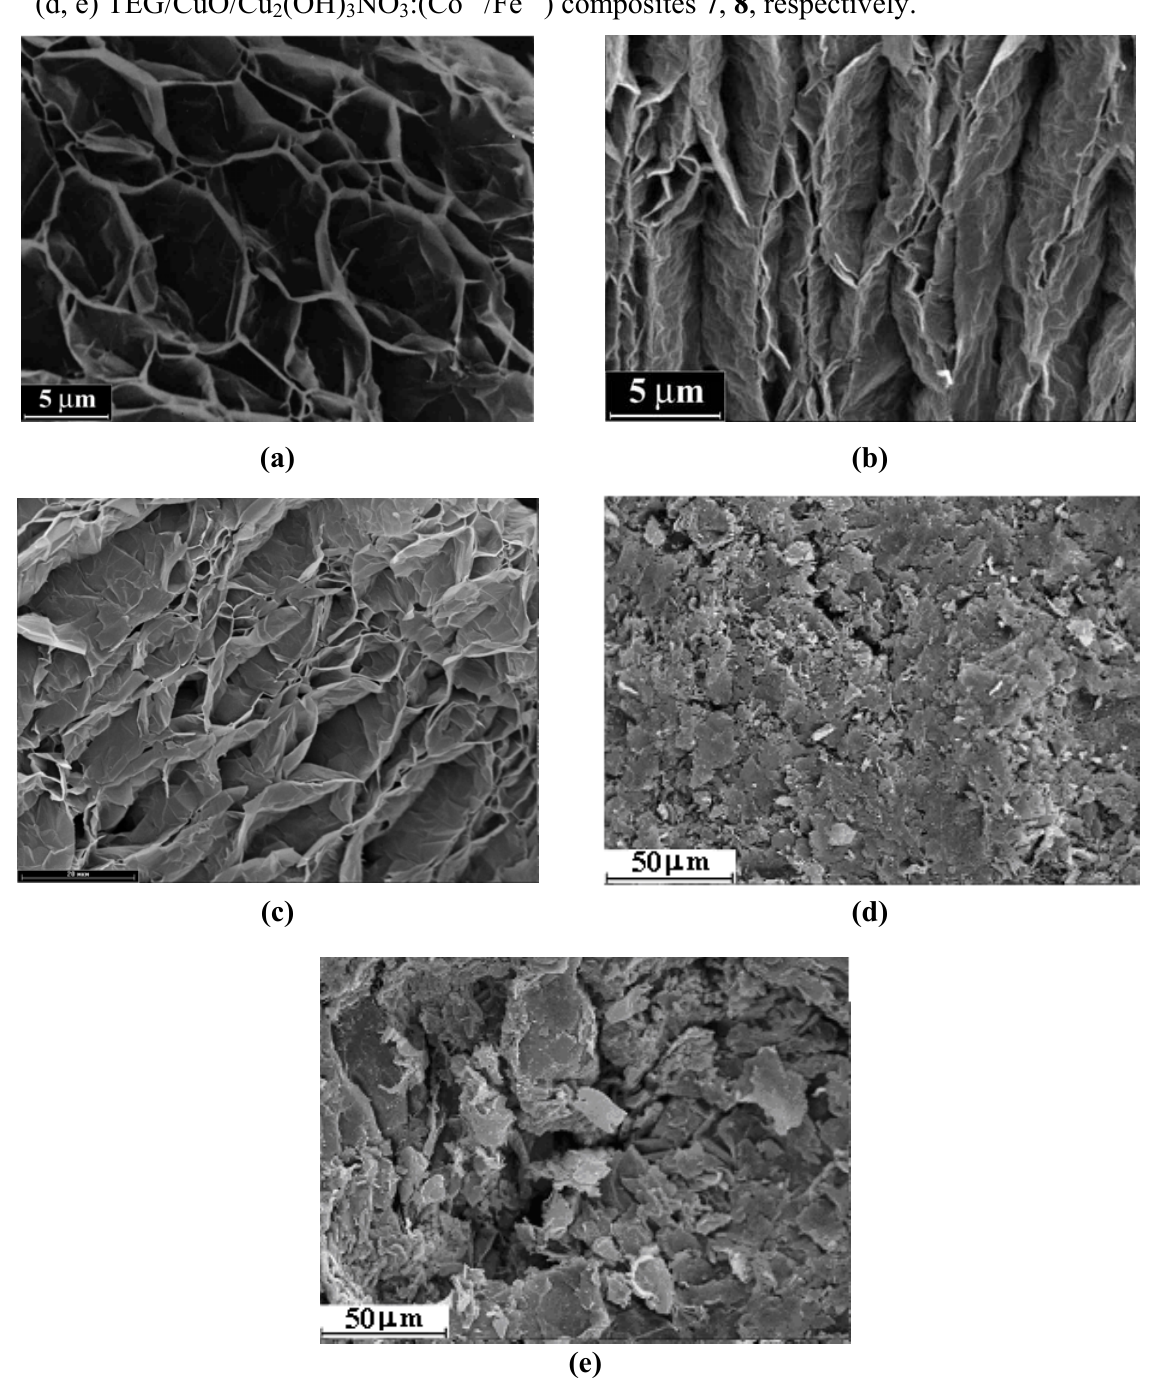
SO , (c) TEG-HNO 2 4